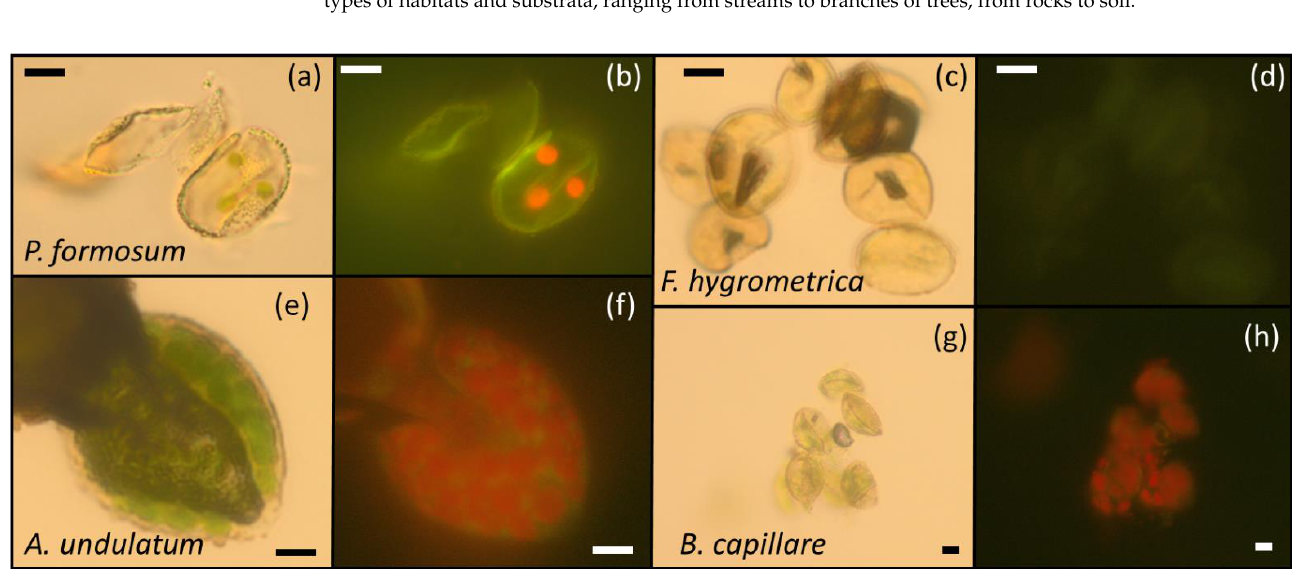
Figure 4. Microscopy images of the spores of P. formosum ( a , b ), F. hygrometrica ( c , d ), A. undulatum ( e , f ) and B. capillare ( g , h ). ( a , c , e , g ) were taken by an optical microscope under white light. ( b , d , f , h ) were taken by epifluorescence after excitation at 450–480 nm (blue filter). Green plastids or chloroplasts are clearly visible in P. formosum ( a ), A. undulatum ( e ) and B. capillare ( g ), particularly due to the red autofluorescence emitted ( b , f , h ), respectively. Table 3. Summary of collection data for the species and accessions of bryophytes harvested for this work. Collection data include location, exposition, coordinates, date of collection and ecology. Ad- ditionally, the presence of chloroplasts and chlorophyll in the spore samples is indicated.